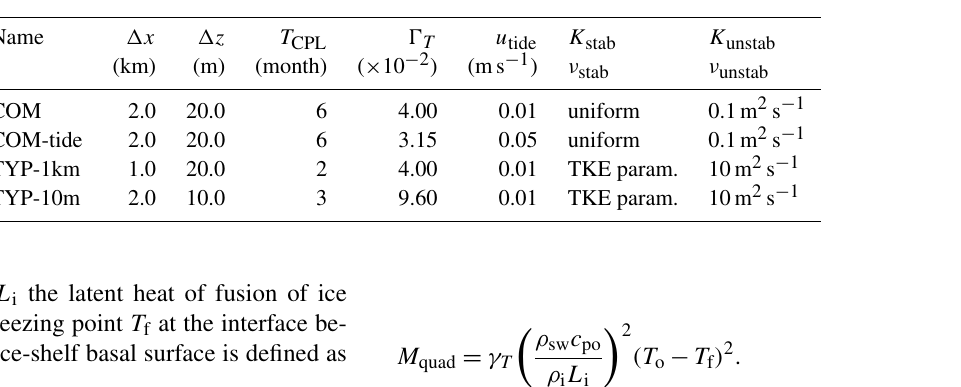
Figure 1. NEMO-Elmer/Ice coupling framework. T and S stand for temperature and salinity. Table 1. Ocean parameters used for the four NEMO-Elmer/Ice coupled simulations. (cid:49)x is the horizontal resolution, T CPL is the ocean–ice- sheet coupling period and (cid:49)z is the nominal vertical resolution. The actual resolution near the sea floor or ice shelf draft can be smaller due to the use of partial steps, but the TBL thickness is always equal to (cid:49)z (i.e. TBL quantities are averaged over several levels in the case of partial steps). (cid:48) T and u tide are defined in Eq. (1), and the salt exchange coefficient (cid:48) S is taken as (cid:48) T / 35. Also defined in Eq. (1) is the drag coefficient C d = 2 . 5 × 10 − 3 . The stable vertical diffusivity and viscosity coefficients ( K stab and ν stab respectively) are either constant, at the same values as in Asay-Davis et al. (2016), or calculated through the TKE scheme with the same parameter values as in Treguier et al. (2014). Convection is parameterised through enhanced diffusivity and viscosity ( K unstab and ν unstab respectively) in case of static instability (0.1m 2 s − 1 as Asay-Davis et al., 2016 and 10m 2 s − 1 as Treguier et al., 2014). The remaining parameters are exactly the same as in the common ISOMIP + configuration described in Asay-Davis et al.